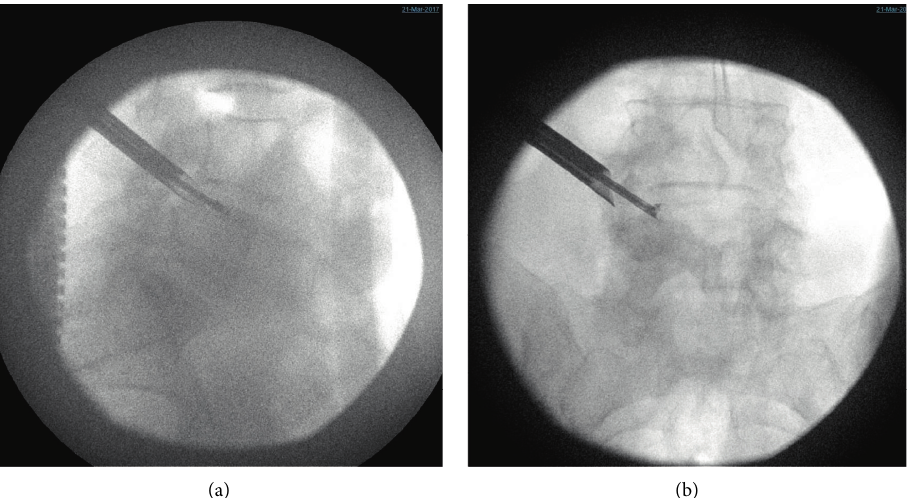
Figure 3: Intraoperative fluoroscopy. (a) Lateral fluoroscopic image of the beveled tubular retractor and endoscope at the L4-5 foramen. A semibendable grasper is displayed removing disc. (b) AP fluoroscopic image of the beveled tubular retractor and endoscope in the foramen and the rigid endoscopic grasper removing herniated disc.